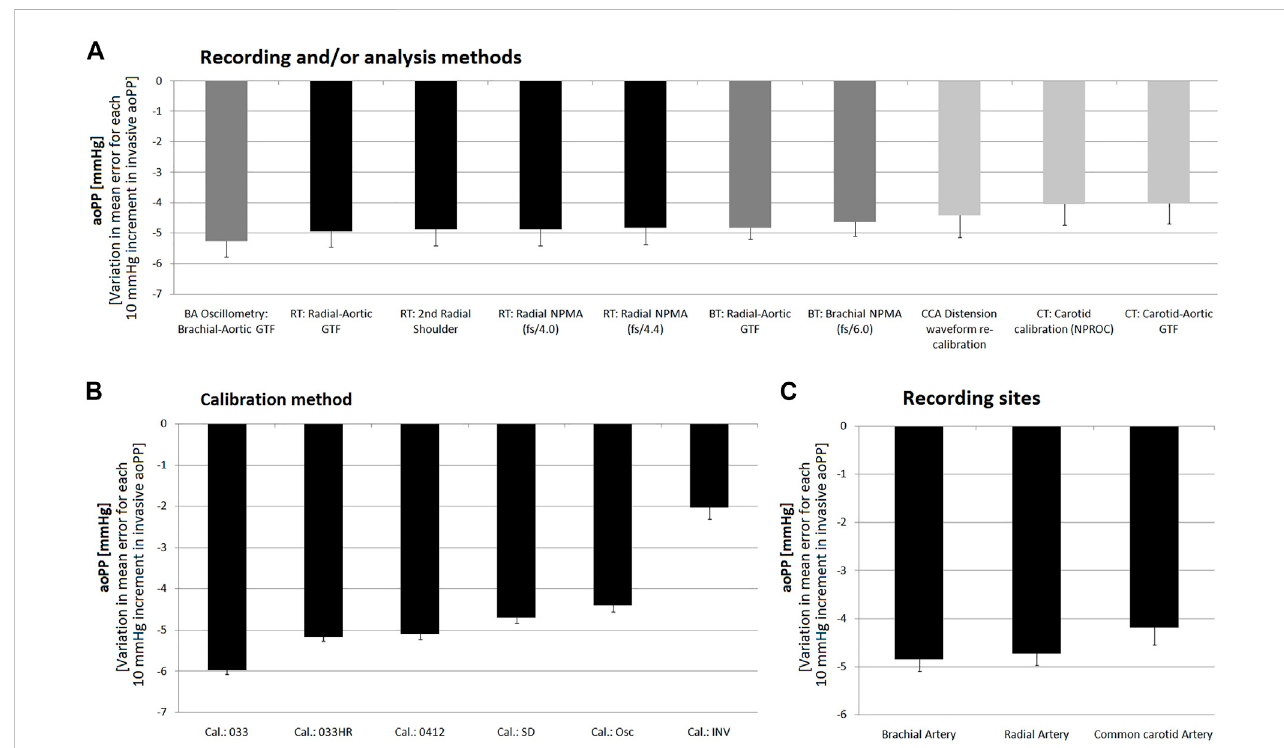
FIGURE 10 Pooled results for Bland-Altman derived proportional errors (and lower or upper 95% con fi dence limit) obtained for comparisons between non-invasive and invasive aoPP measurements. Results grouped according to: (A) , recording and/or analysis methodology; (B) : calibration scheme; (C) : recording